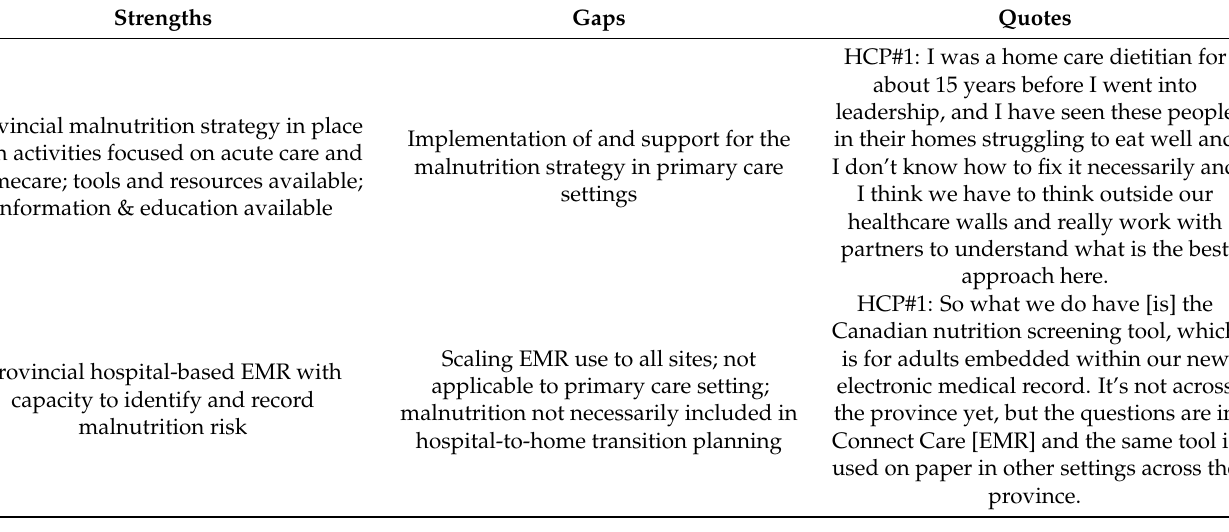
Table 3. Current state strengths and